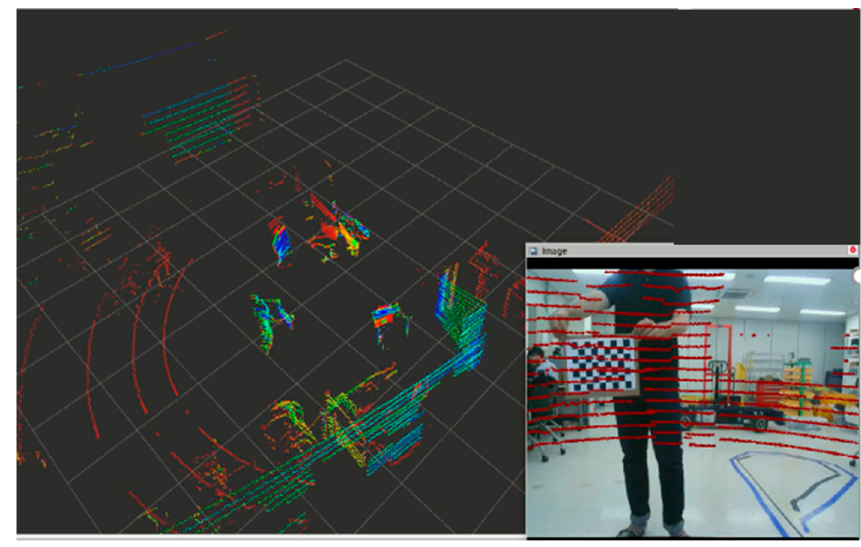
Figure 12. Camera-LiDAR Projection.